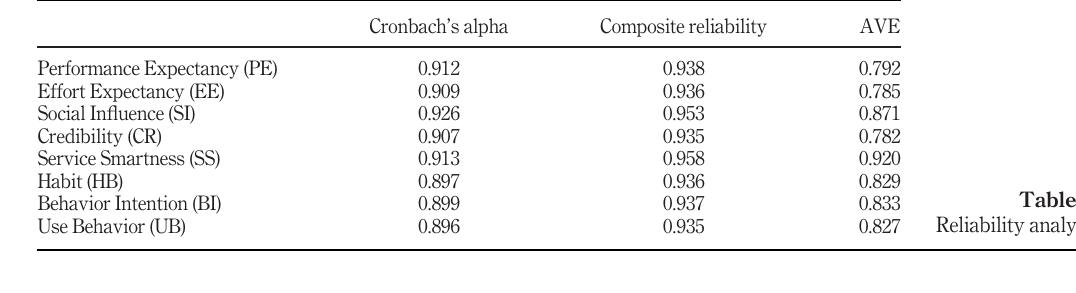
Table 5. Reliability analysis